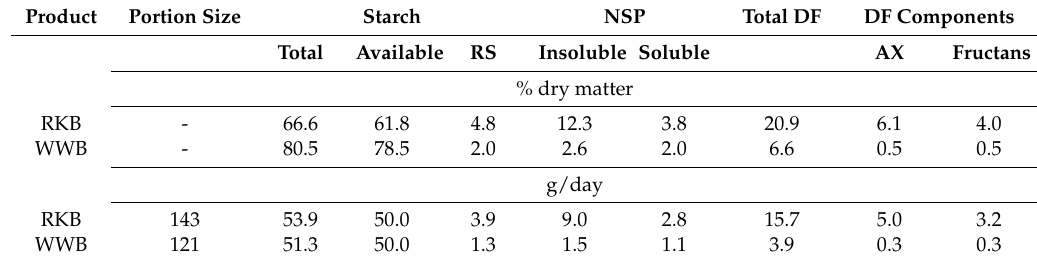
Table 1. Carbohydrate composition and portion size of the evening meals RKB and WWB, respectively 1